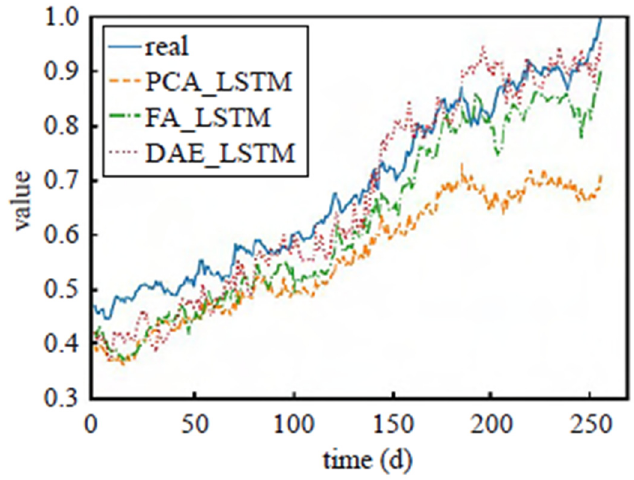
Figure 7. The results of predicting stock prices with different coding sequences.